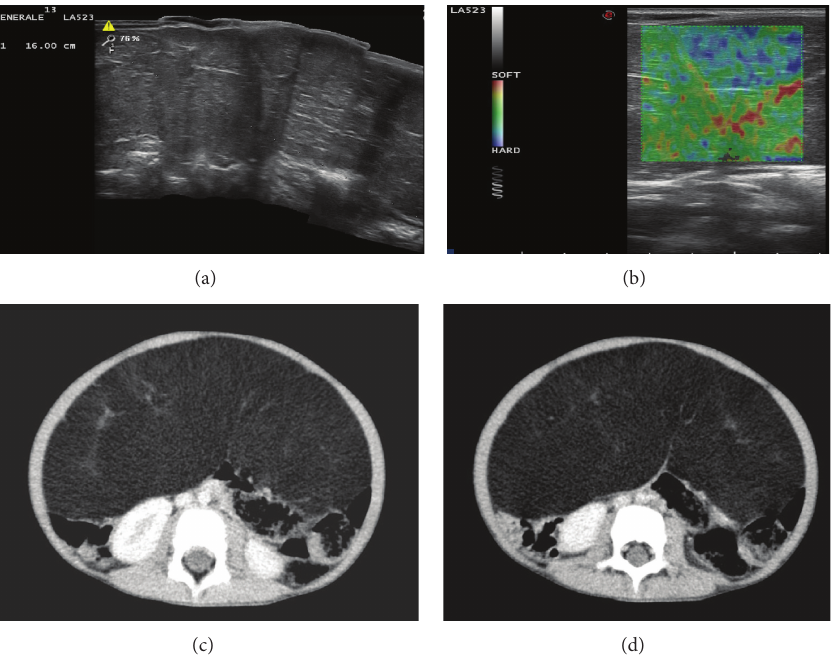
Figure 1: (a) US examination revealed mass had mixed echogenicity with some hyperechoic thin septations. (b) The mass appeared mainly green—soft—on elastosonography. ((c), (d)) CT showed the mass had fatty density with a few septations and no contrast enhancement.